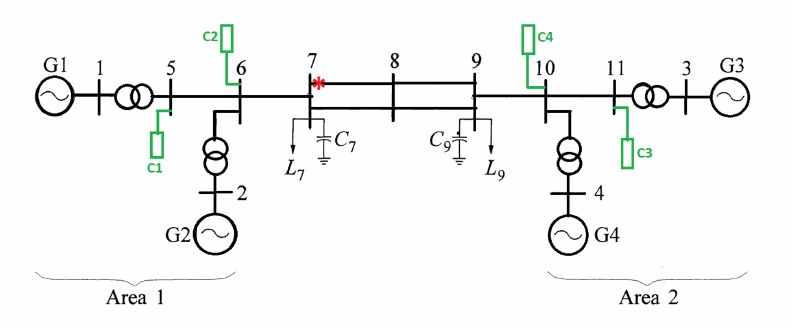
Figure 13. Four-machine two-area power system.